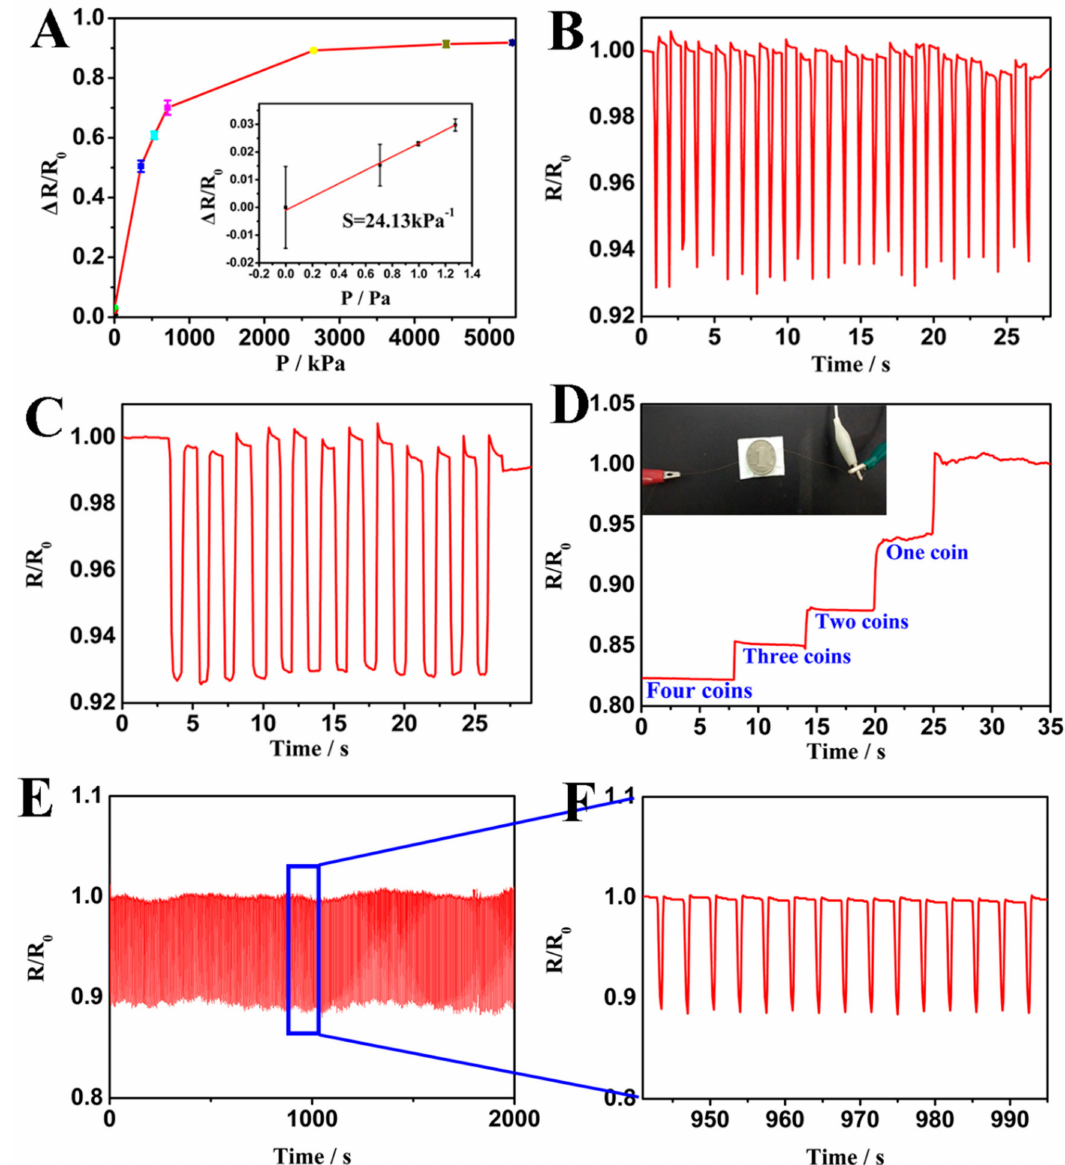
Figure 4. ( A ) Resistance change–pressure relationship; Responses of the sensor to finger tapping ( B ) and pressing ( C ); ( D ) Relative resistance of the sensor after loading different numbers of coins; ( E ) Responses of the nanofiber mats-based piezoresistive sensor upon repetitive loading and unloading of a constant pressure; ( F ) An enlarged view of the selected